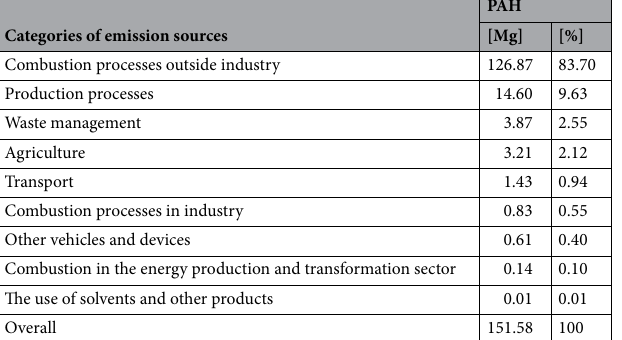
Categories of emission